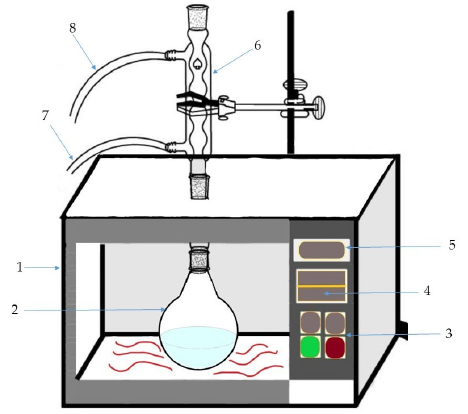
Figure 4. Schematic diagram of the microwave ‐ assisted distillation apparatus 1. microwave oven, 2. glass flask, 3. irradiation power controller, 4. time controller, 5. display, 6. condenser, 7. inlet water, 8. outlet water. Table 4. Full factorial design 33 and experimentally observed